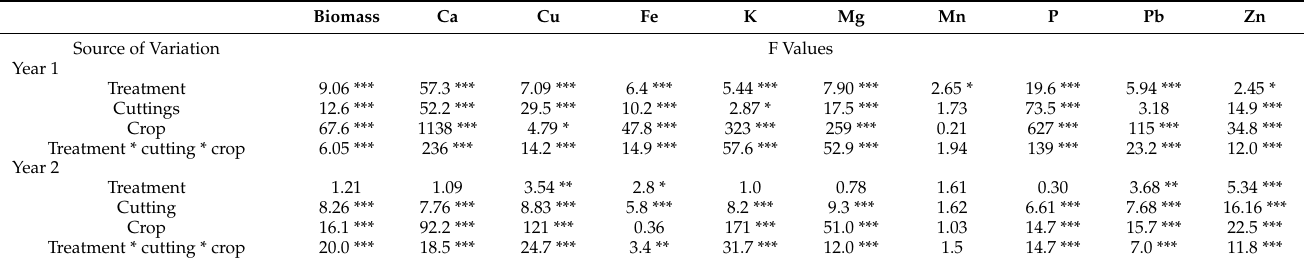
Table 6. F statistics and significance levels for treatments and cuttings for the first and second year. Biomass Ca Cu Fe K